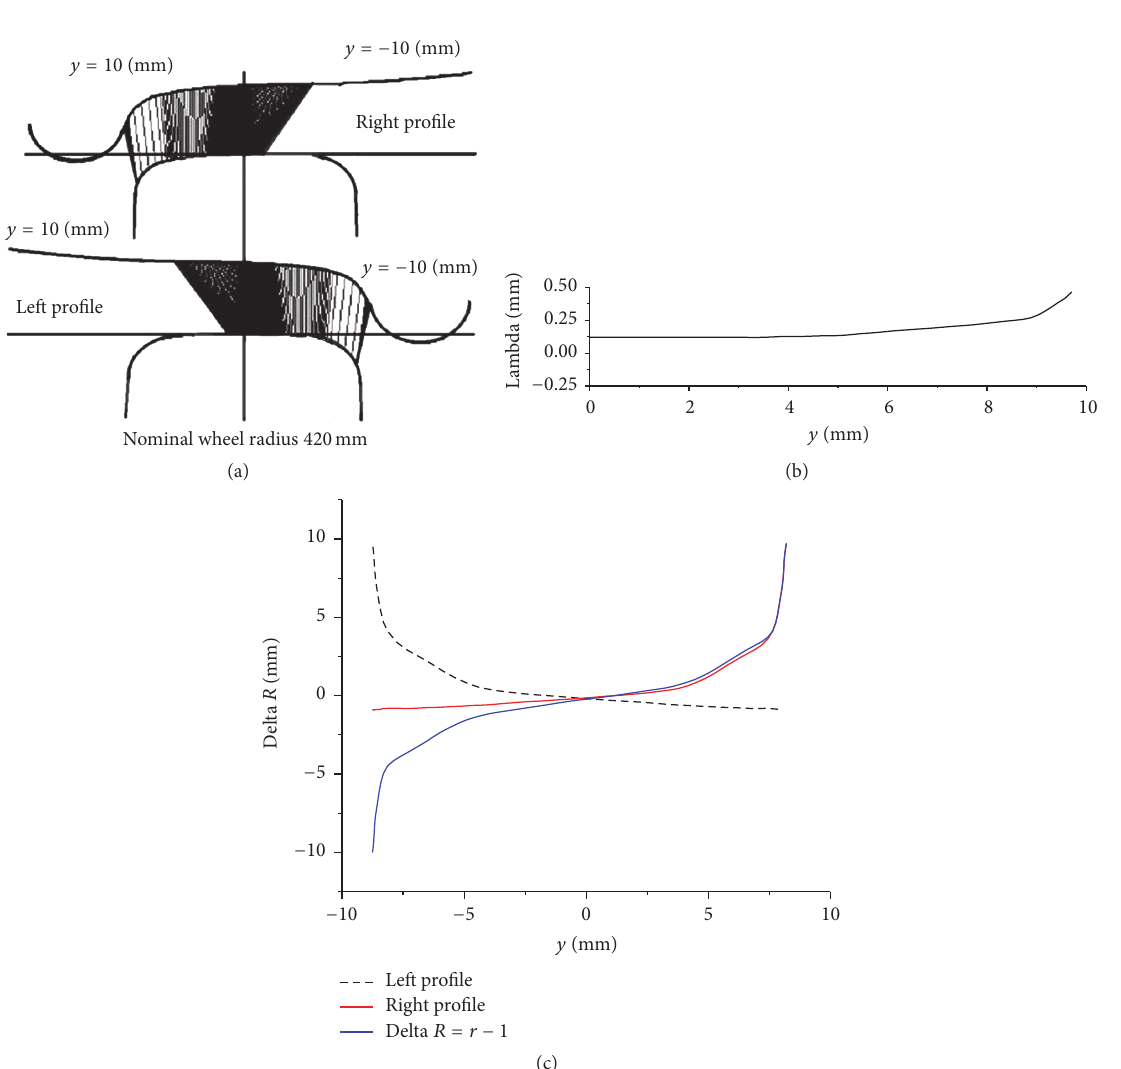
Figure 5: (a) Radial bogie and (b) TFDA-bogie.